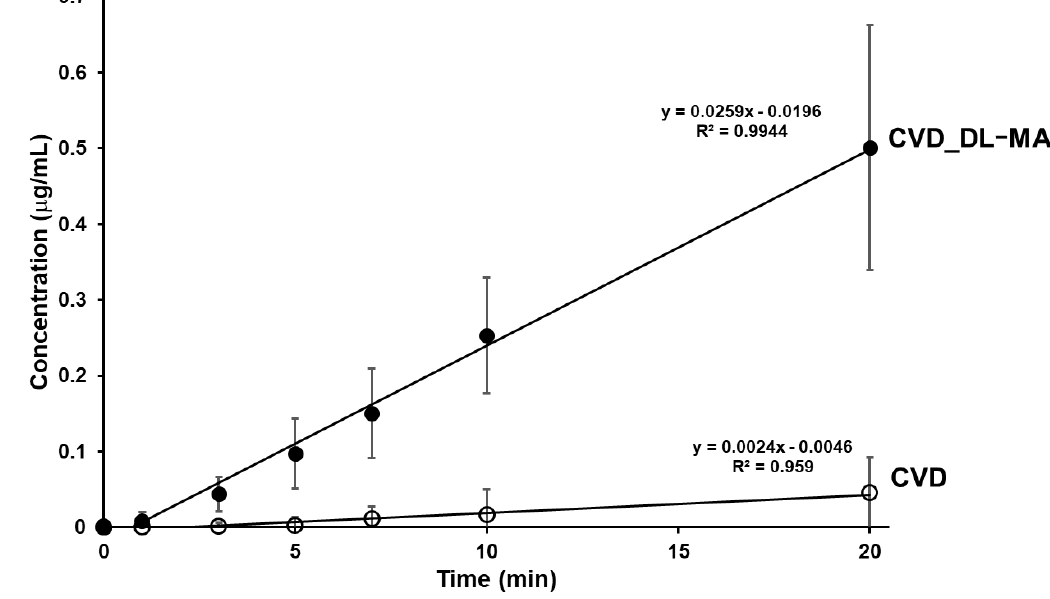
Figure 11. Intrinsic dissolution rate profiles of CVD and CVD_DL-MA.